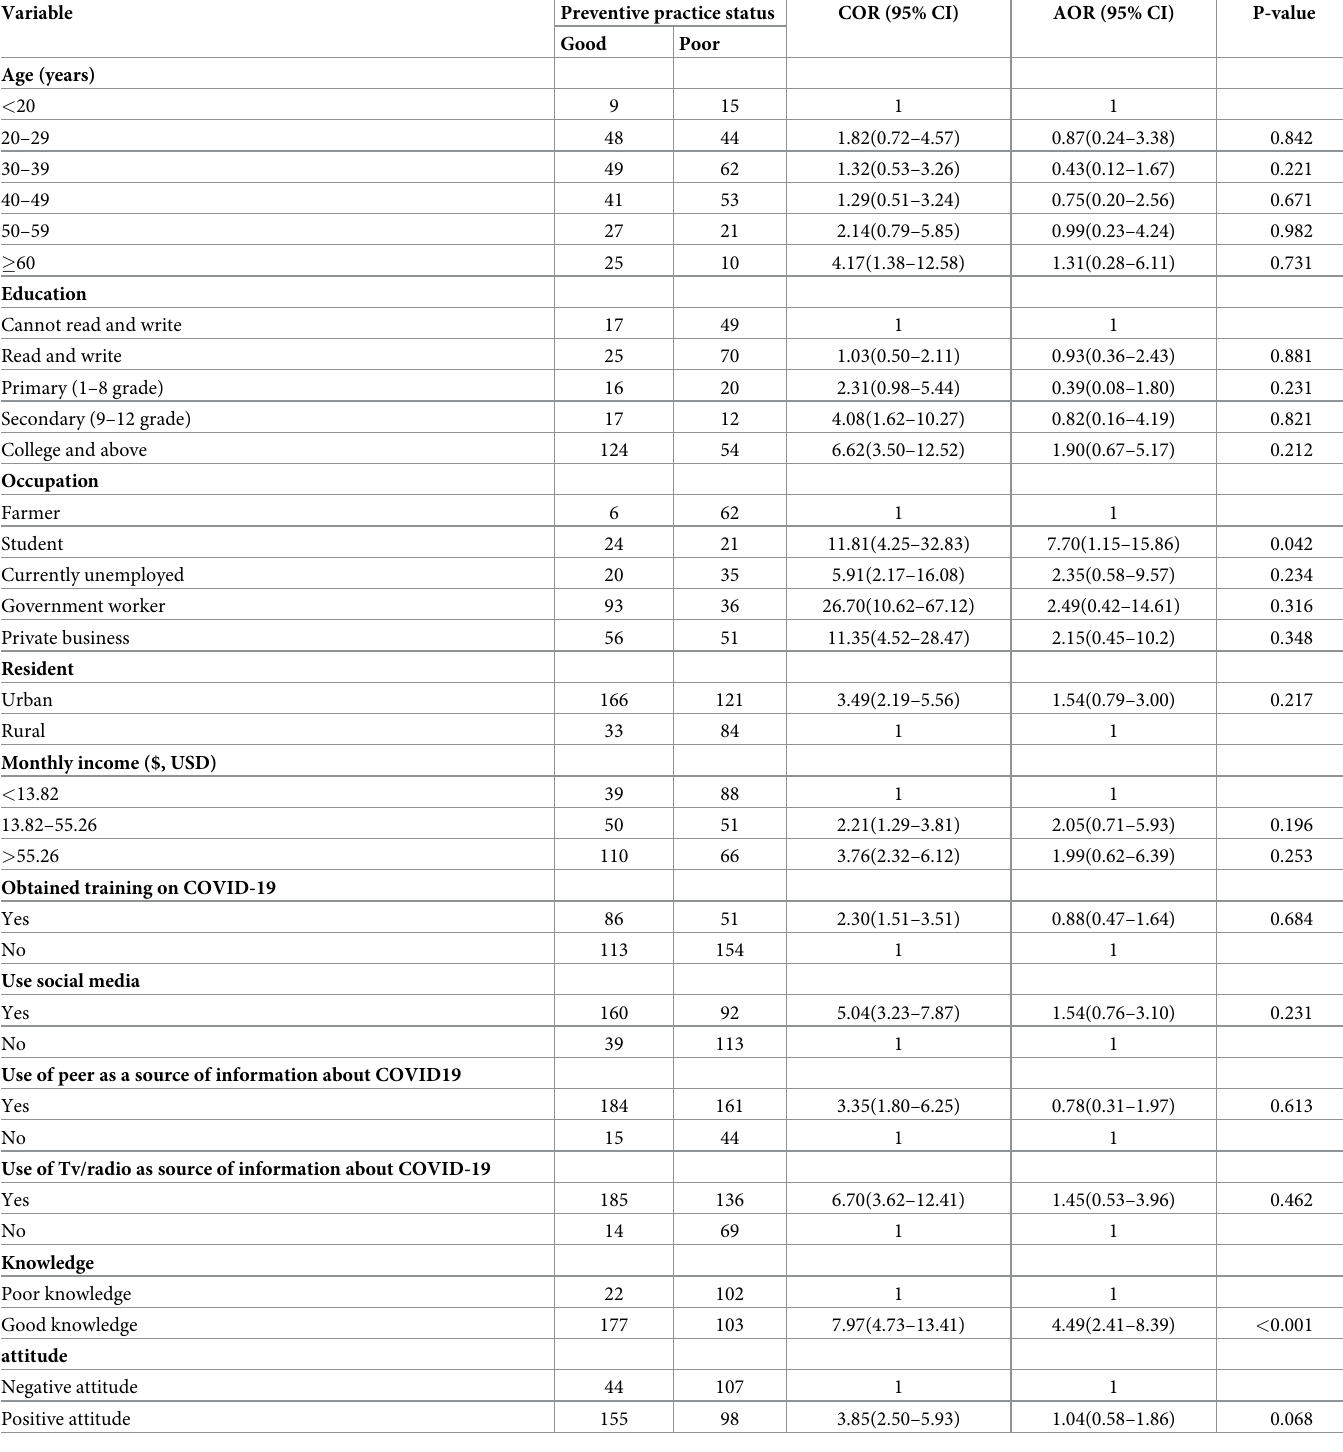
Table 7. Factors associated with preventive practice towards COVID-19 prevention among adult visitors in hospitals of South Gondar zone, Northwest Ethiopia, in August 1 to 30, 2020.